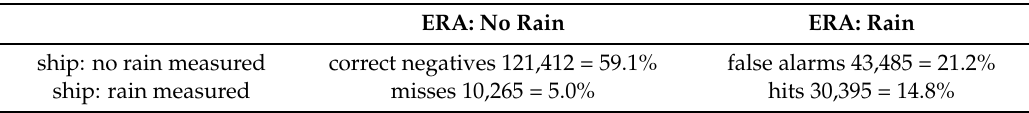
Table 1. Contingency table for binary statistics of collocated events of ERA-Interim rain data and rain measurements on ships. The total number of collocated events is 205,557. The numbers of the proportions to the total number are also